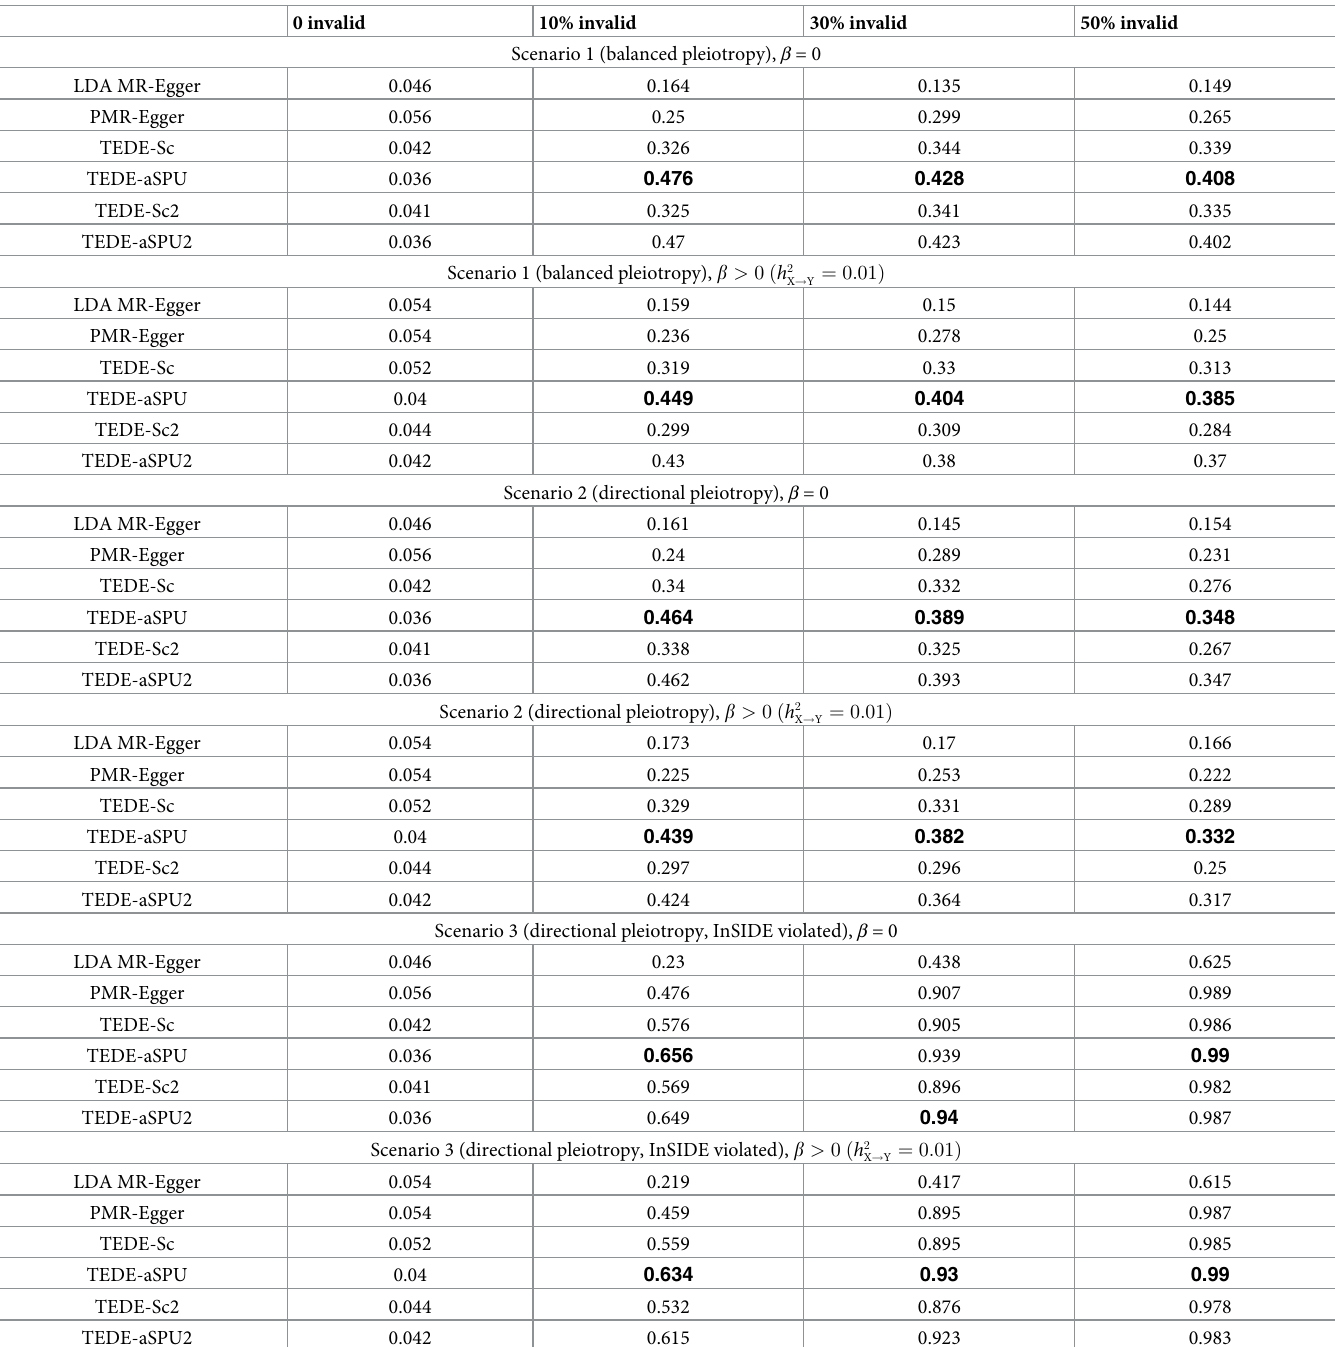
Table 4. Rejection rates (type I error when there is 0 invalid IV; power otherwise) for testing valid IV assumptions. 1000 iterations. p = 30. High LD ( ρ = 0.7). 0 invalid 10%